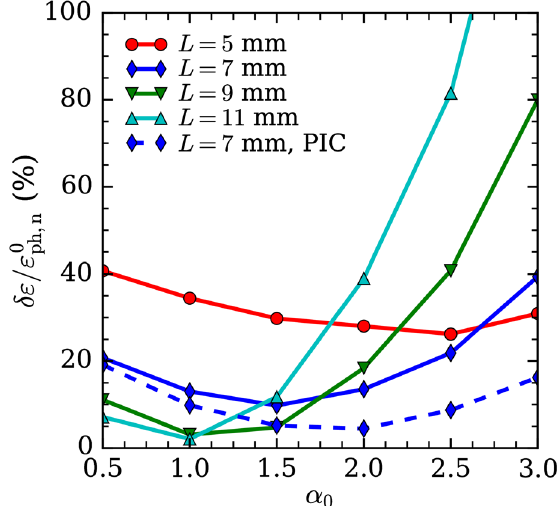
FIG. 2. Emittance growth as a function of α 0 for various ramp lengths, calculated with the A stra code (continuous lines) and one case calculated with the 3D PIC code W arp (dashed